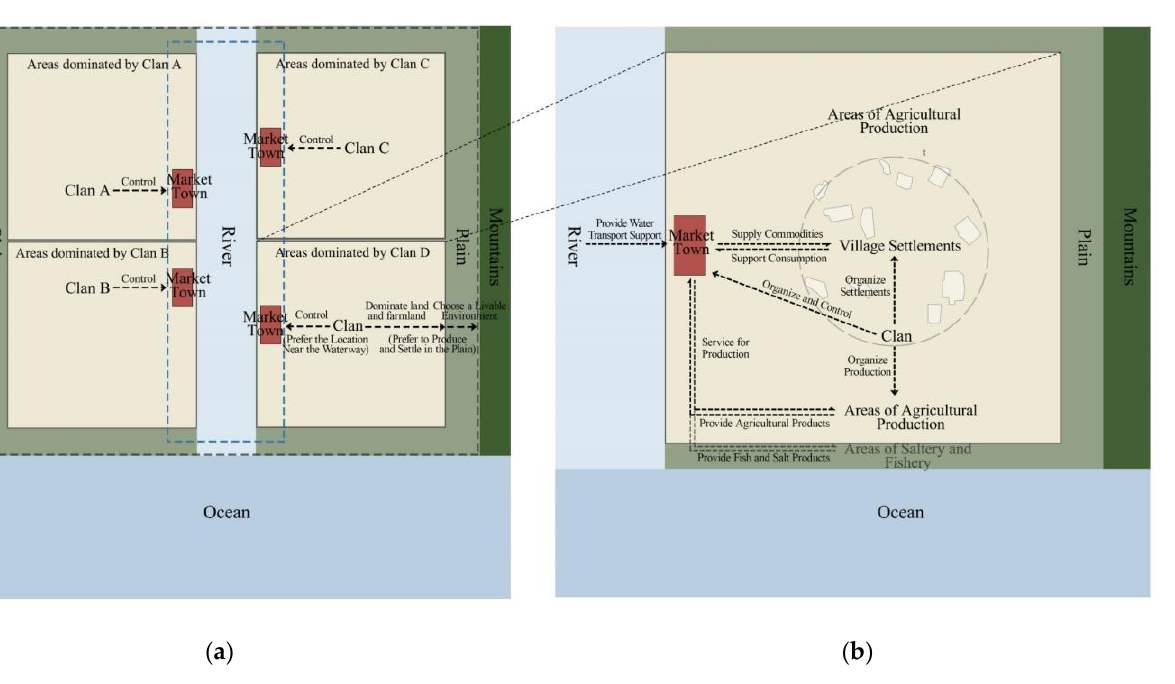
Figure 9. Spatial structure pattern of market towns associated with plains, waterways, and clan vil- lages. ( a ) Clans ’ respective domain units and market towns; ( b ) the spatial pattern of the market town and environmental factors is essentially a reflection of the functioning mechanisms of rural trade, production, and